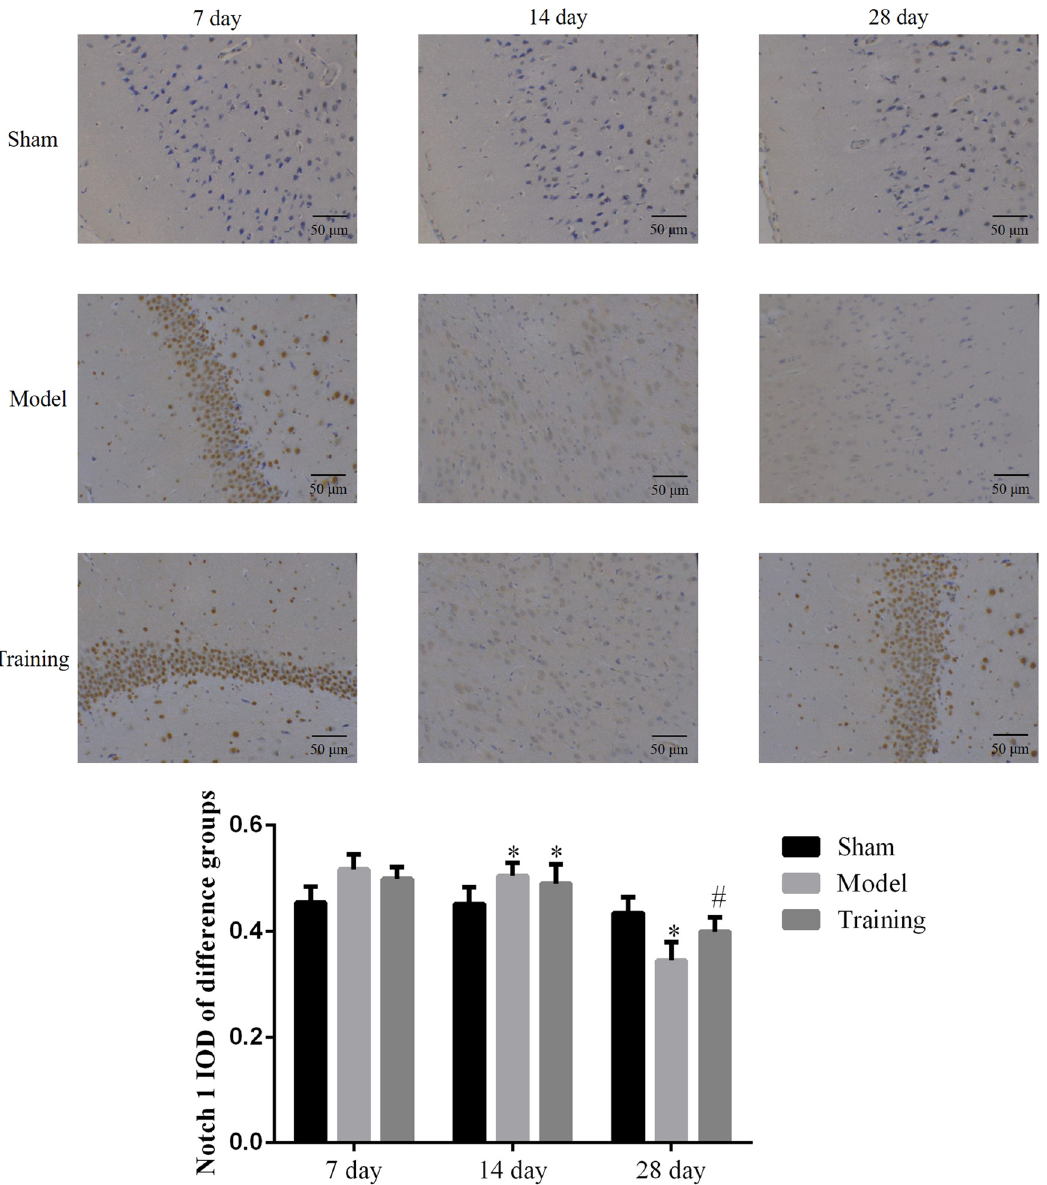
Figure 3: The Notch protein expression of di ff erent groups by IHC assay (× 200 ) . Sham: Sham group; Model: nerve injuries in CCI rat model; Training: nerve injuries in CCI model rats that were treated with rehabilitation training exercises; * P < 0.05 compared with the Sham group; # P < 0.05 compared with the Model